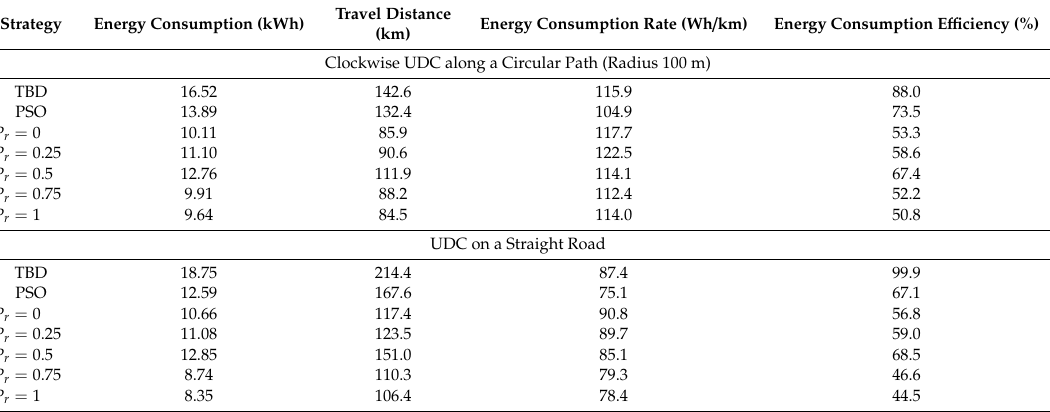
Table 3. Torque and battery distribution strategy results.